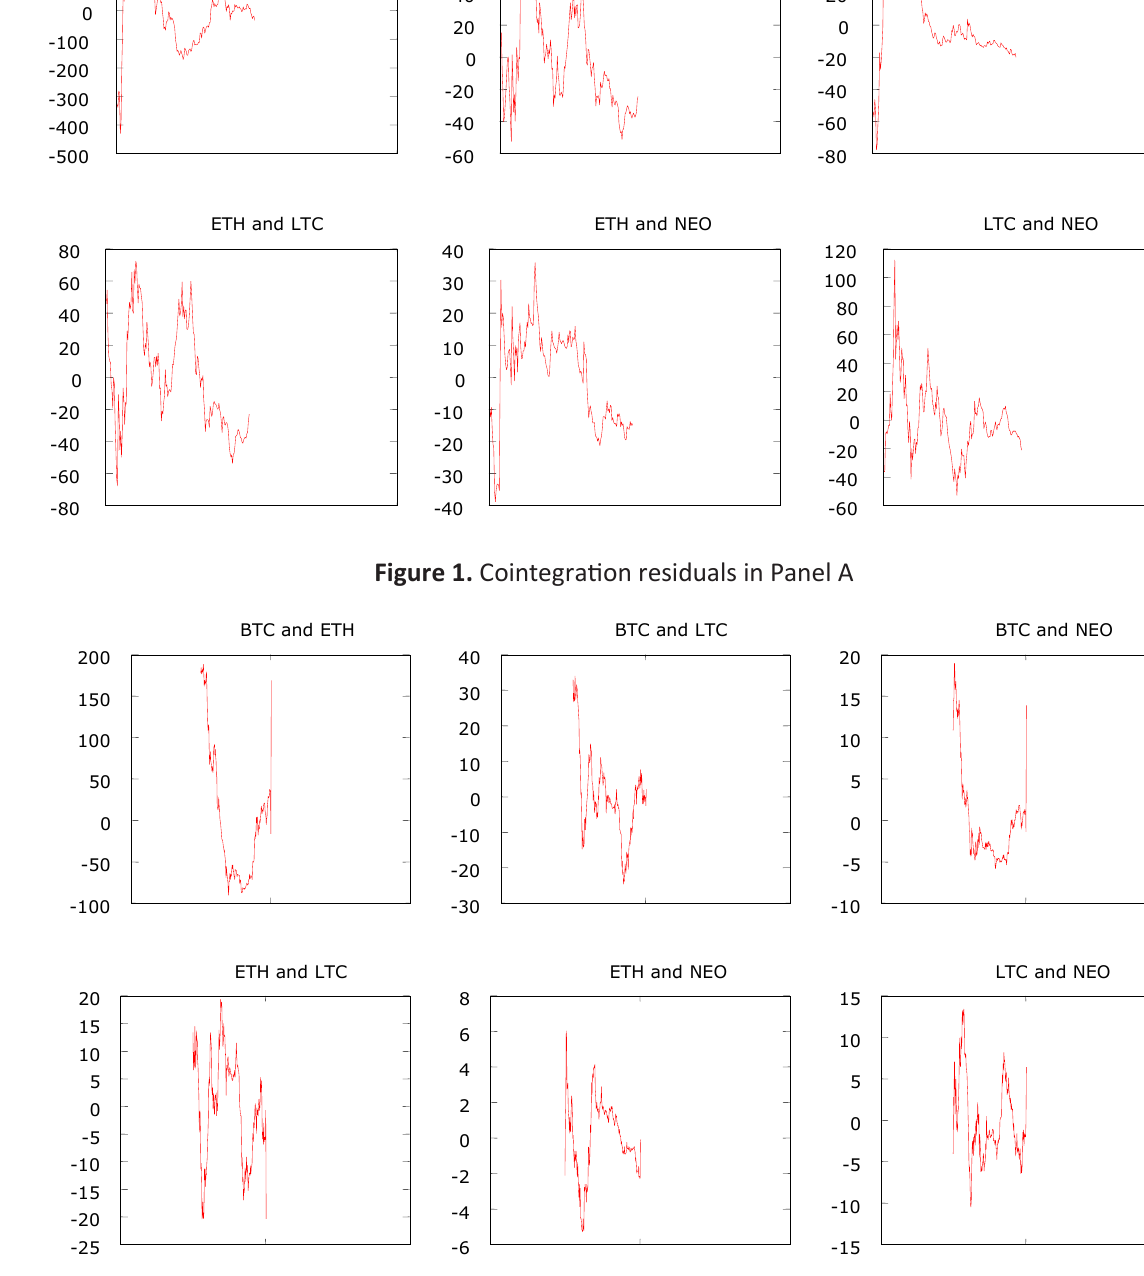
Figure 2. Cointegration residuals in Panel